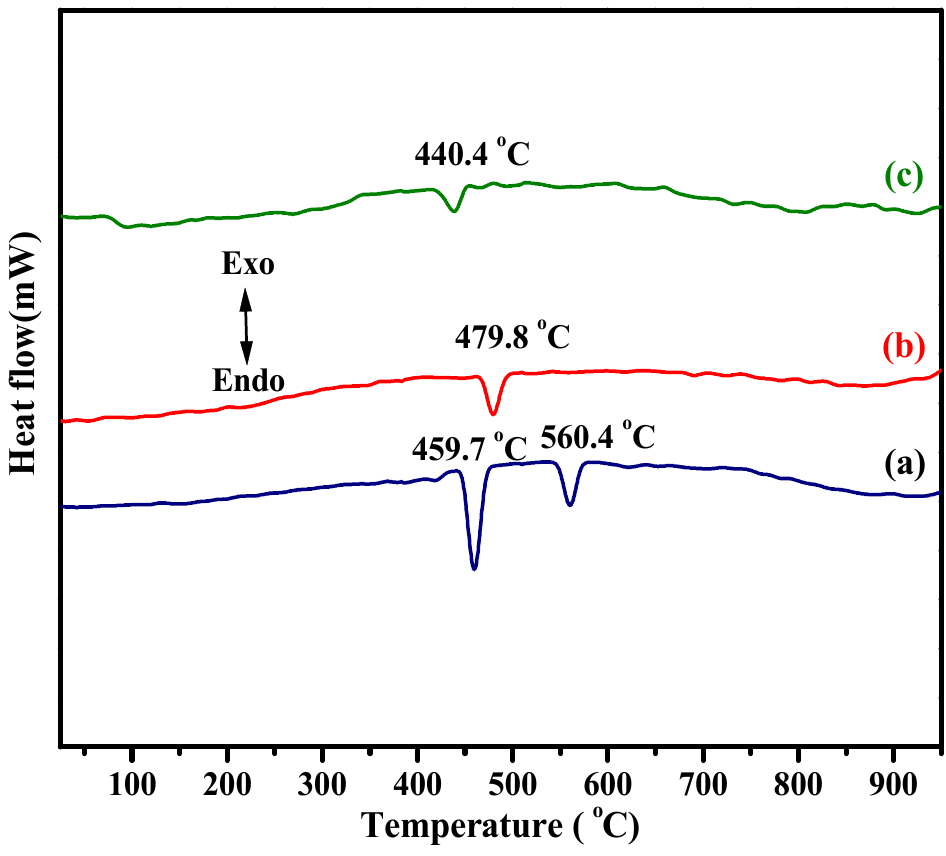
Figure 2. DTA thermograms of BiFeVOx.y for ( a ) y = 0.03, ( b ) y = 0.07, and ( c ) y = 0.15. Table 1. Stabilized phase, refined unit cell parameters, crystallite characteristics of as–prepared BiFeVOx.y photocatalyst series.